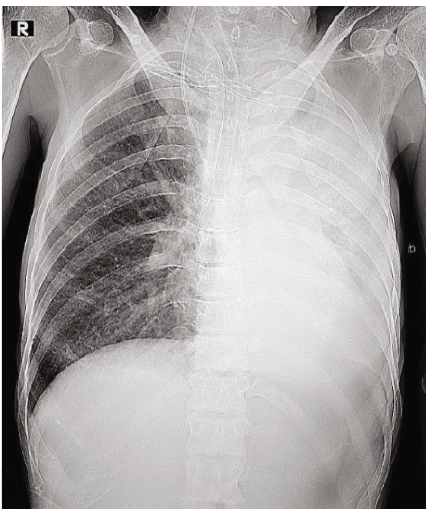
Figure 1: Post tracheostomy insertion portable CXR.